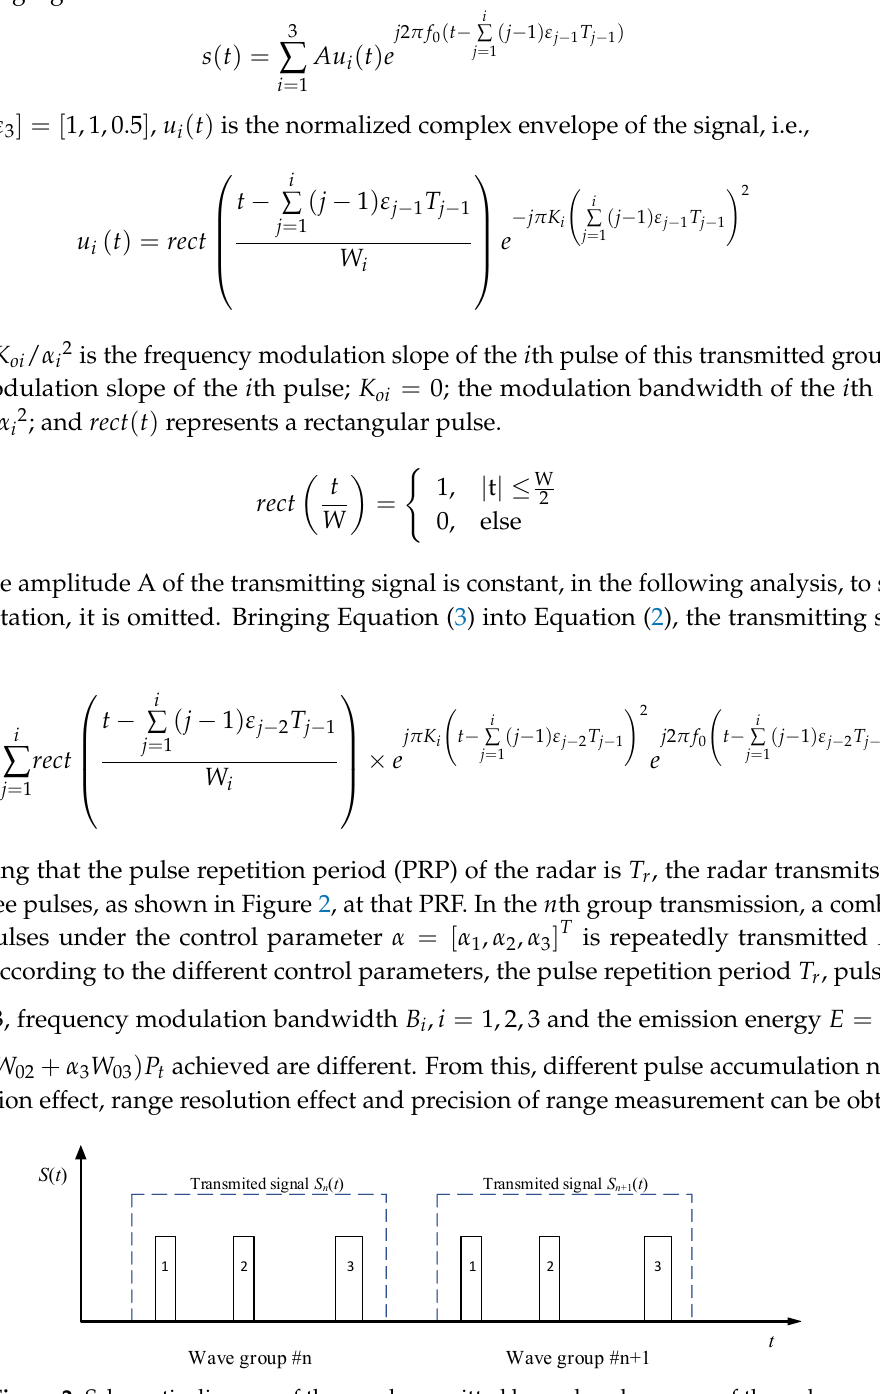
Figure 2. Schematic diagram of three pulses emitted by each pulse group of the